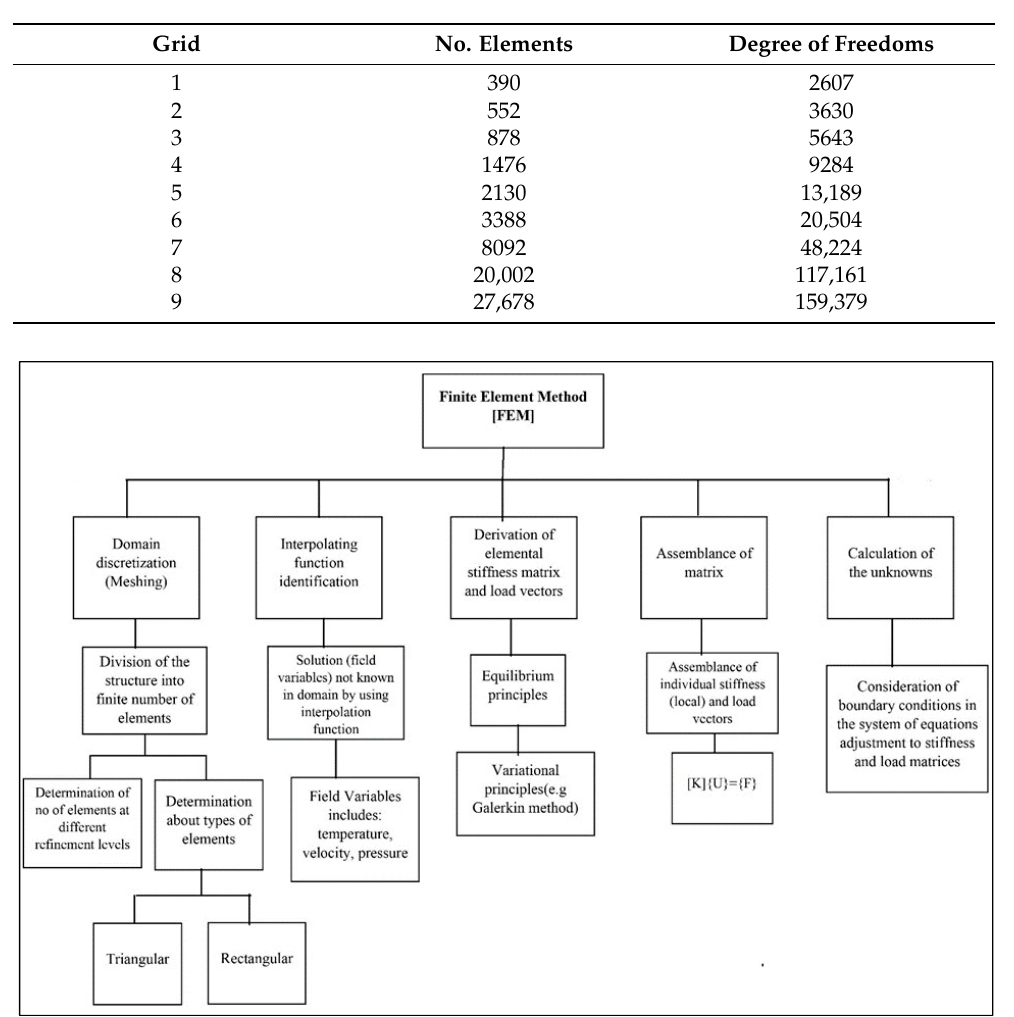
Table 1. Mesh statistics for different levels of refinement.